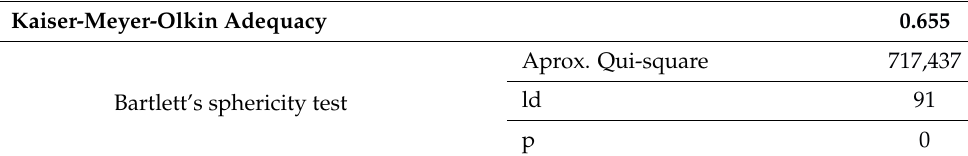
Table 4. KMO and Bartlet tests.